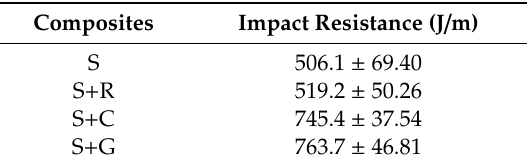
Table 4. Impact tests